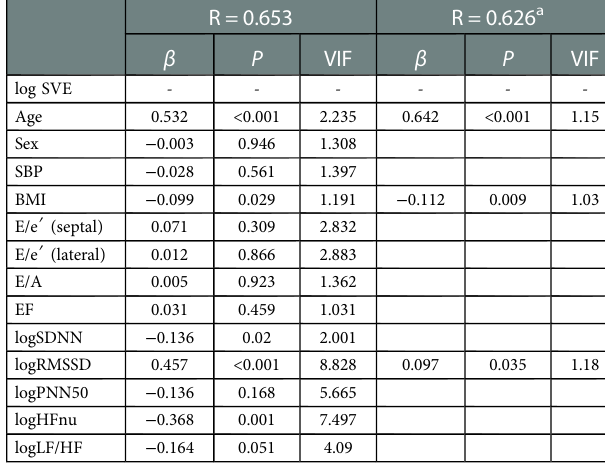
TABLE 6 Multiple regression analysis for log supraventricular ectopy ( N = 365).